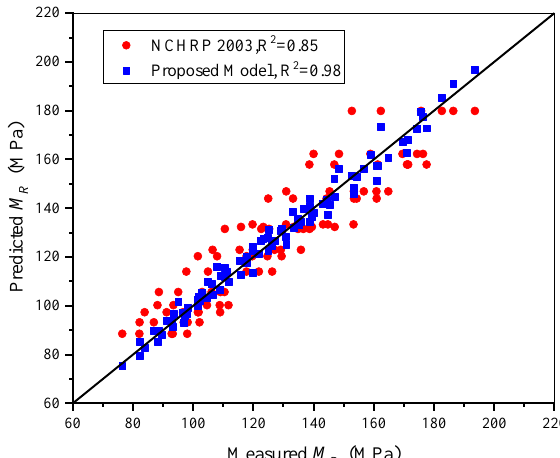
Figure 4. Comparison of the proposed model and the NCHRP 1-28A model.